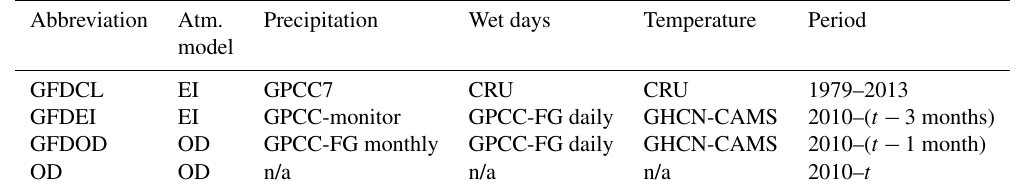
Table 1. Table of meteorological forcing data used in the analyses and hydrological simulations, listing the atmospheric model and the data sources used to adjust the the model for each variable (precipitation, number of wet days, and temperature). The data sets are described in Table 2. Abbreviation Atm.